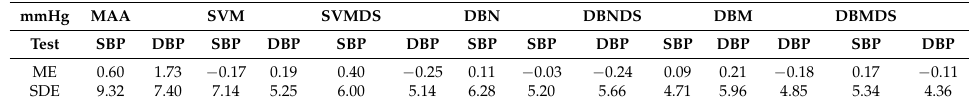
Table 3. The results of ME (mean error) and SDE (standard deviation of error) relative to the target results obtained with the conventional MAA (maximum amplitude algorithm), SVM [28], SVMDS, DBN [10], DBNDS, DBM [12], and DBMDS scheme, where the results are the mean values for our test data.